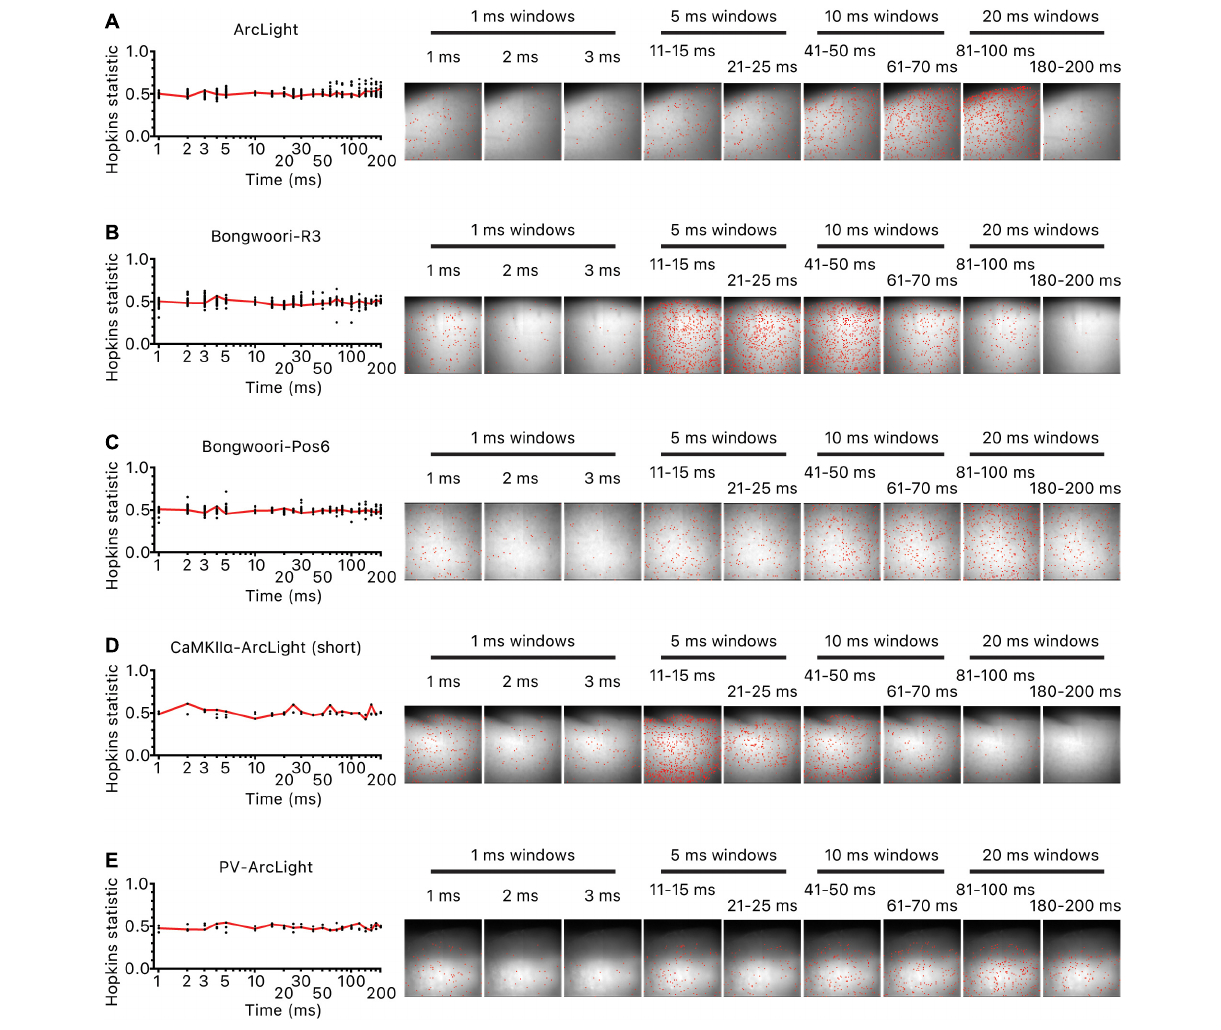
FIGURE 5 | Lack of clustered origins of oscillations. For each oscillation, the initiation time point of each unmasked pixel was ordered and binned in 1/5/10/20 ms time bins for the first 200 ms of the oscillation. For each time bin, as many pixels were selected at random as the pixels in the time bin, and the Hopkins statistic was calculated. The process was repeated 20 times and averaged. The red line is the averaged values. Hopkins statistic close to 0 indicates uniform distribution, 0.5 indicates no clustering, and 1 indicates clustering of pixels. Hopkins statistic and location of pixels that started oscillating in each time bin for (A) representative hSyn-ArcLight oscillation, (B) representative hSyn-Bongwoori-R3 oscillation, (C) representative hSyn-Bongwoori-Pos6 oscillation, (D) representative CaMKII α -ArcLight (short) oscillation, (E) representative PV-ArcLight